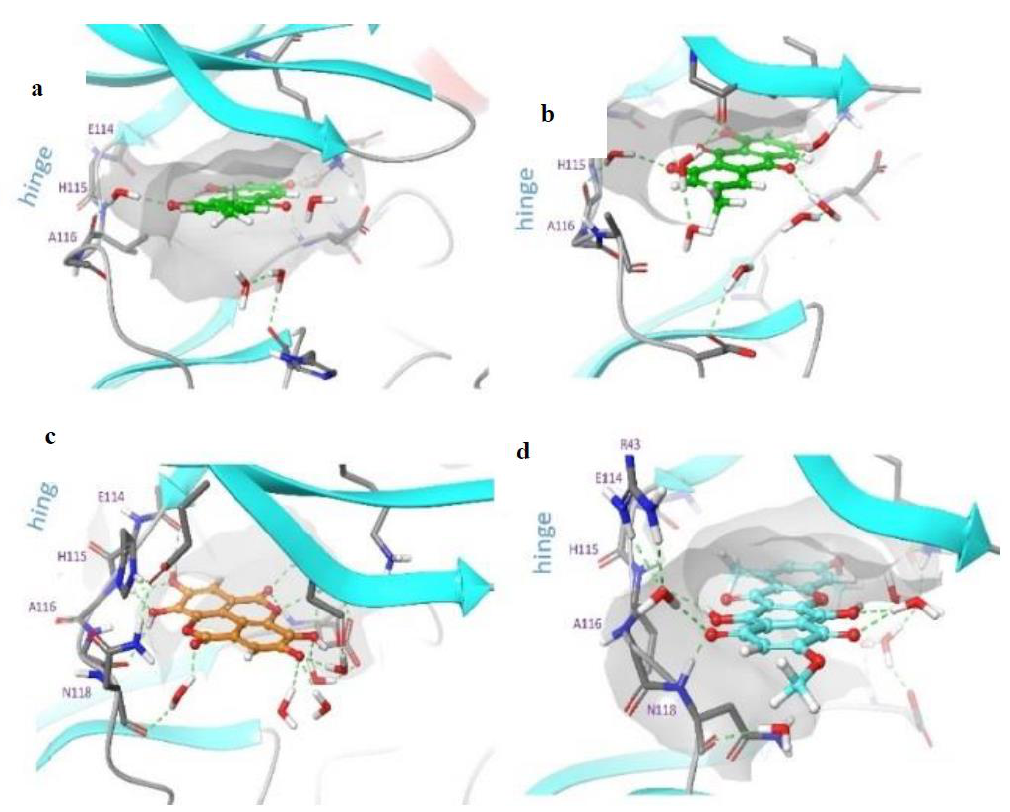
Figure 11. Snapshot structure of protein–ligand complexes at a time point of 100 ns. ( a ) presents an original PDB structure 1C13 (emodin), ( b ) emodin, ( c ) ellagic acid and ( d ) bikaverin. Only key interacting residues and the closest water molecules are shown for clarity. The orange dots represent negatively charged residues, violet dots represent the positively charged residues, green dots represent the hydrophobic regions, blue dots represent polar regions, and grey dots represent the water molecule.